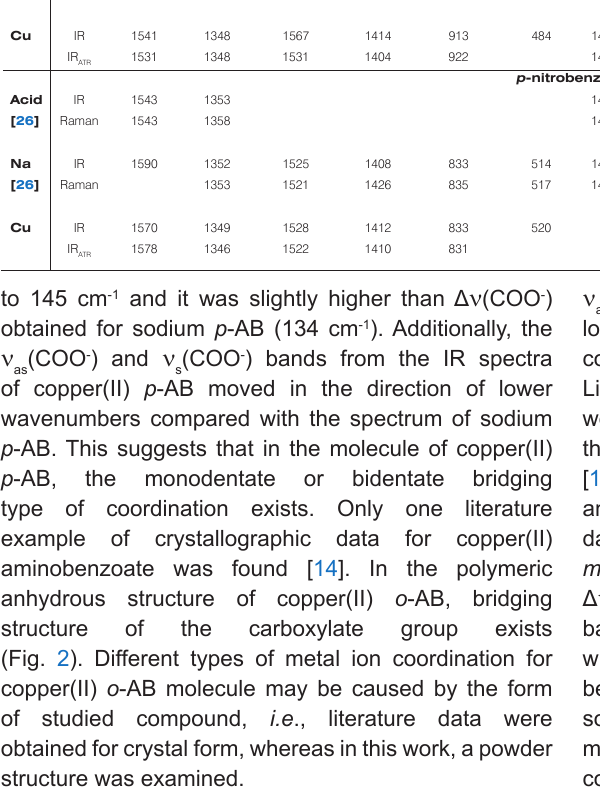
(Fig. 2). Different types of metal ion coordination for copper(II) o -AB molecule may be caused by the form of studied compound, i.e ., literature data were obtained for crystal form, whereas in this work, a powder structure was